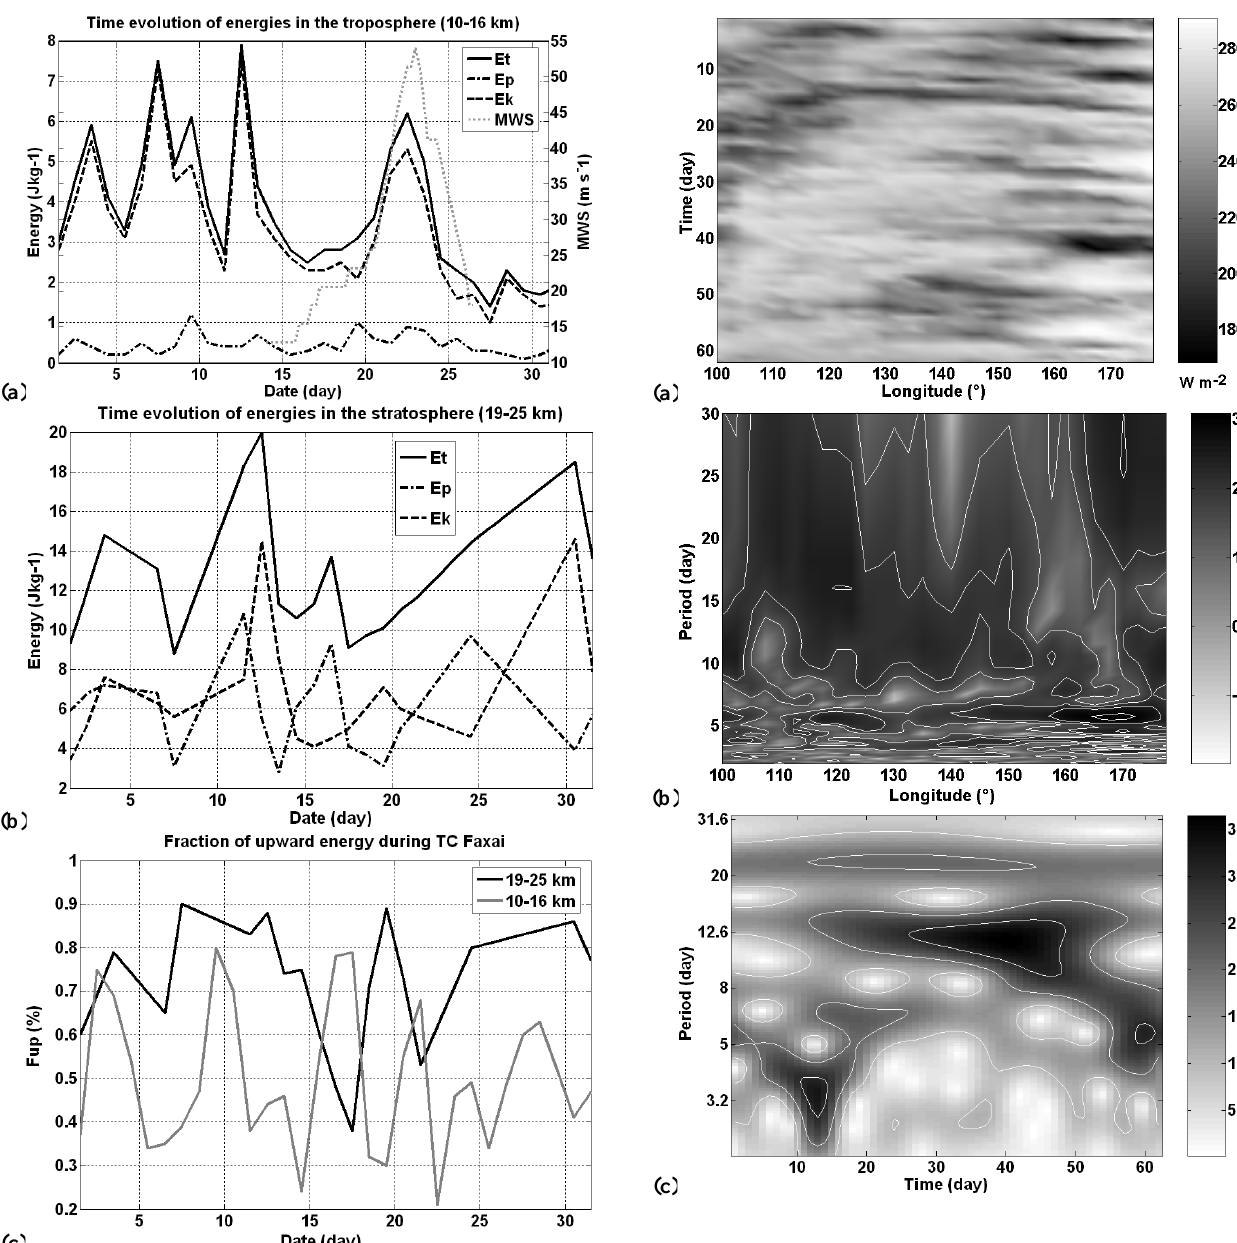
Fig. 10. Daily evolution of total, potential and kinetic energies from 2 successive radiosonde data 00:00UT and 12:00UT in (a) the UT and (b) the LS and (c) the corresponding fraction of upward energy. The maximum surface wind of TC Faxai is plotted (dotted grey line on Fig. 10a).